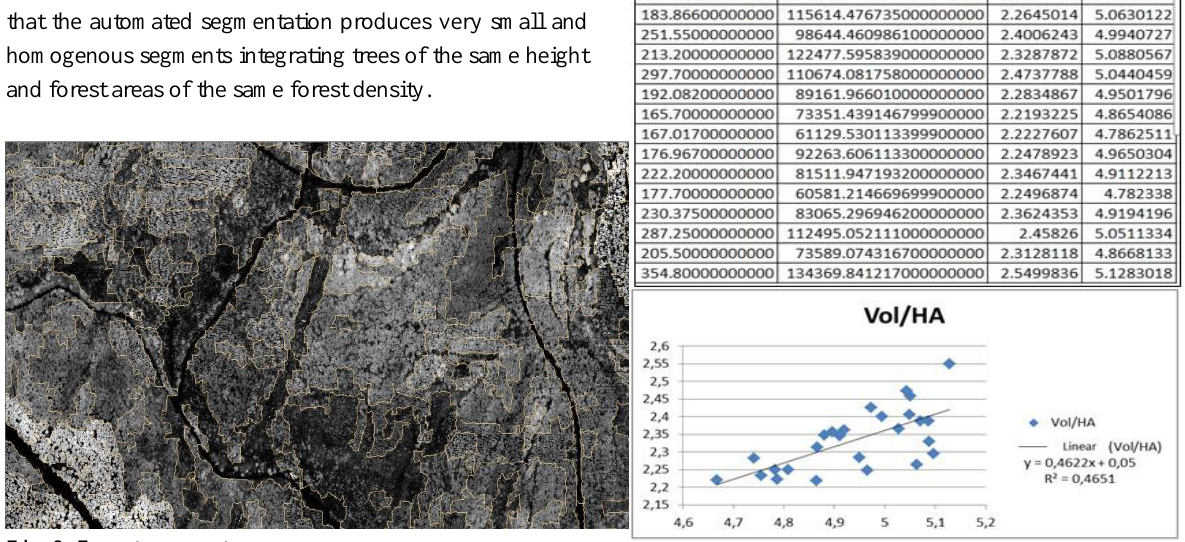
Fig. 9. Regression between timber volume and canopy space